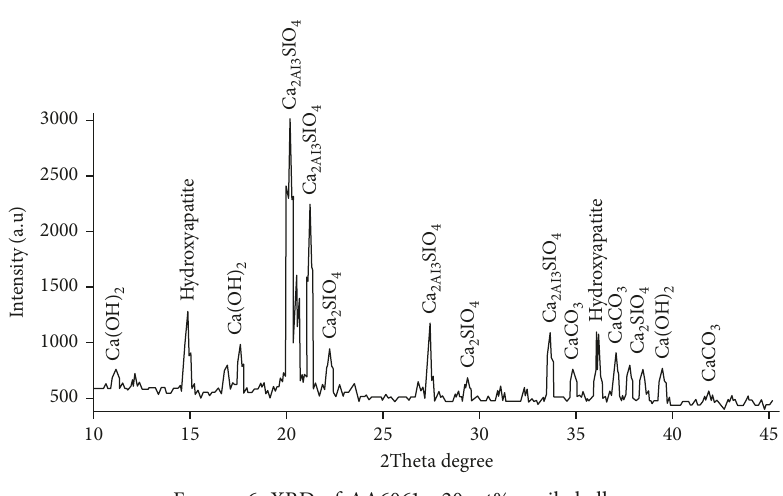
Figure 6: XRD of AA6061+20 wt% snail shell.